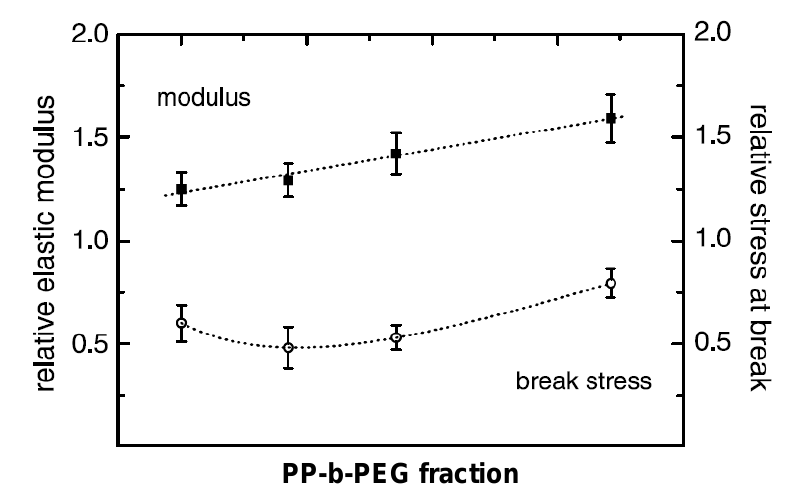
Figure 31. Increase in the tensile modulus of the polyethylene nanocomposites as a function of the amount of the compatibilizer. The filler content was fixed at 3 vol%. Reproduced from reference [136] with permission from Elsevier.